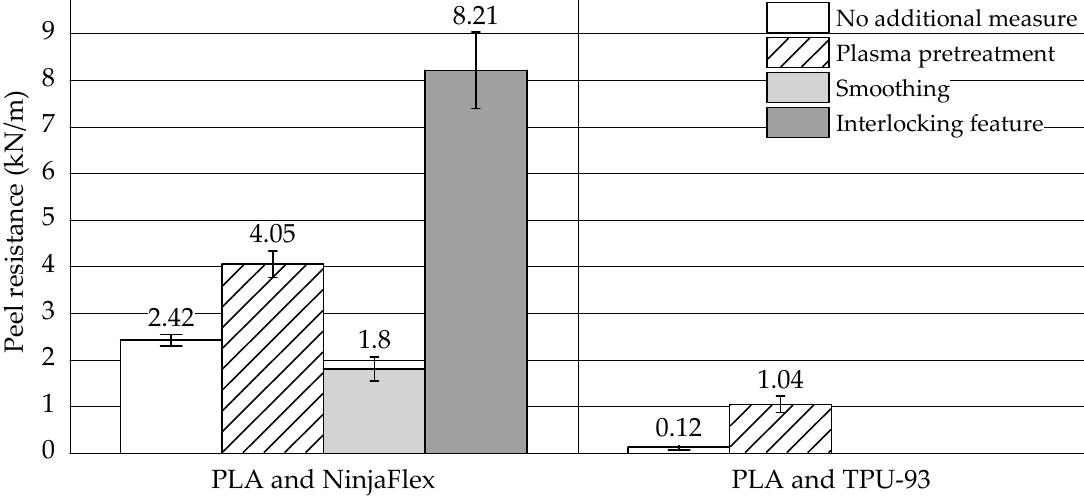
Figure 10. Comparison of different additional measures in order to increase the interface strength of selected material combinations.